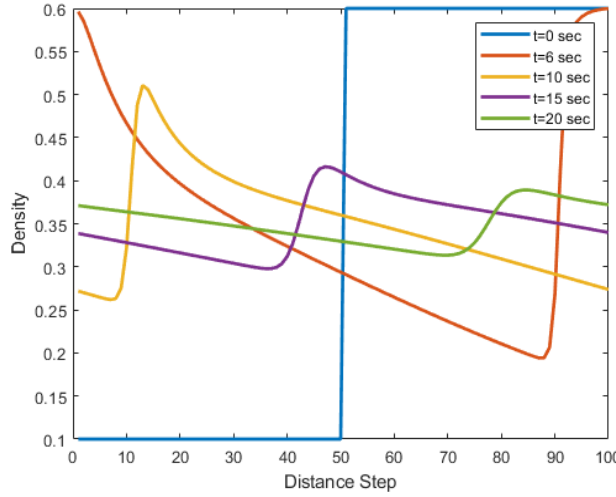
Figure 17. Density behavior of the proposed model on a ring road.